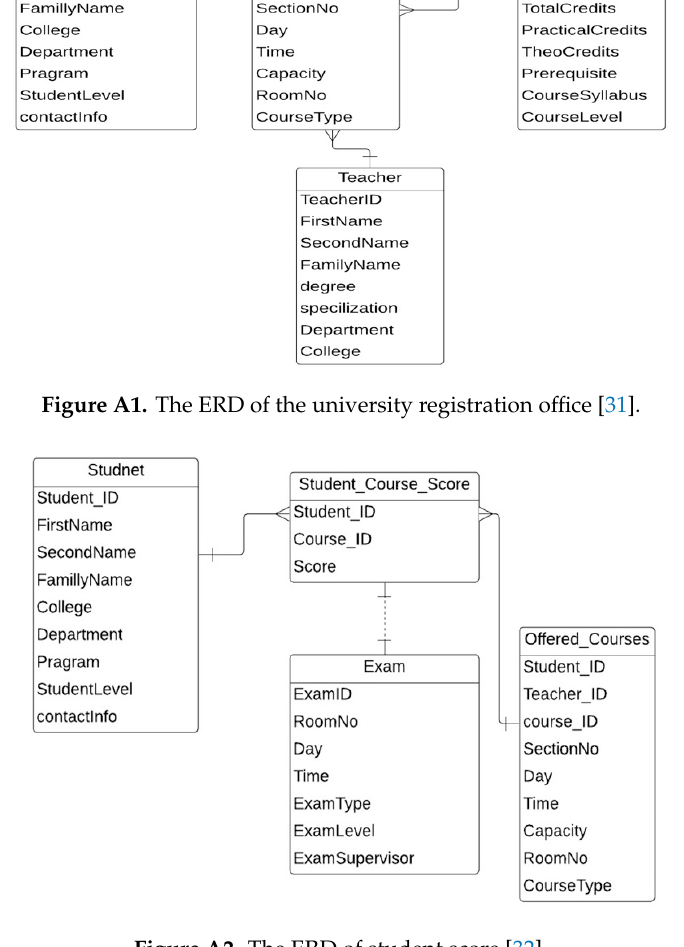
Figure A2. The ERD of student score [32]